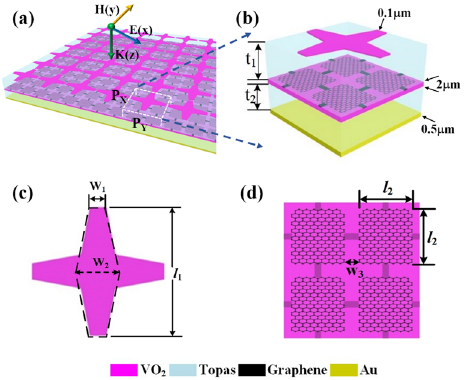
Figure 1. ( a ) The overall diagram of the designed structure; ( b ) Three-dimensional image for the unit cell; ( c ) The top view of the top VO 2 metamaterial patch; ( d ) The schematic diagram of the graphene patch layer.